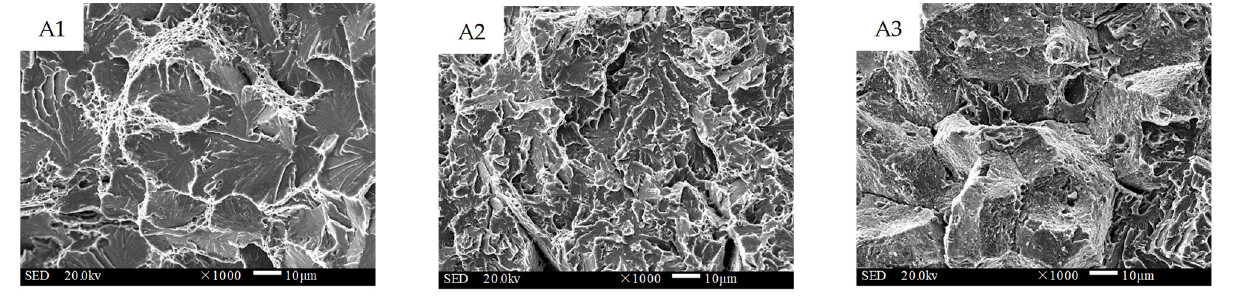
Figure 13. Impact fracture morphology of interface A between the substrate and the transition layer (1000×).